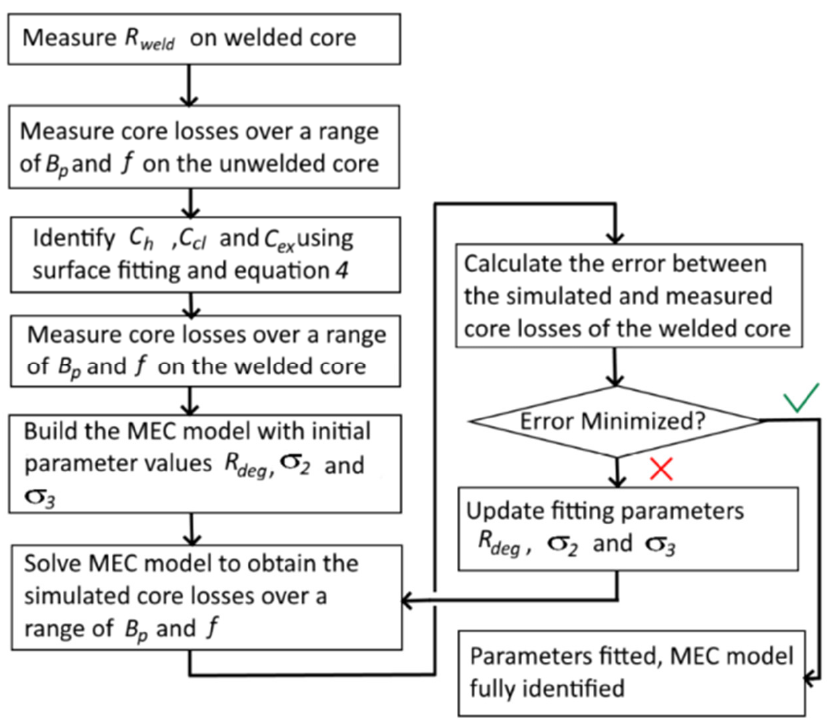
Figure 7. Flowchart describing the methodology for applying the MEC model.